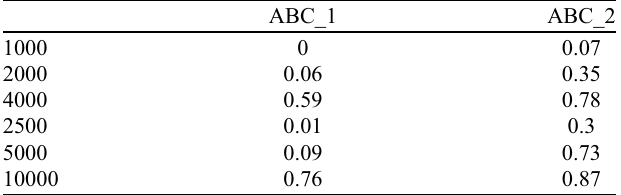
Table 5. Comparison of different variants of ABC algorithm for Example 2 (Orthogonally stiffened cylindrical shell)) with different function evaluations for the success rate obtained in 100